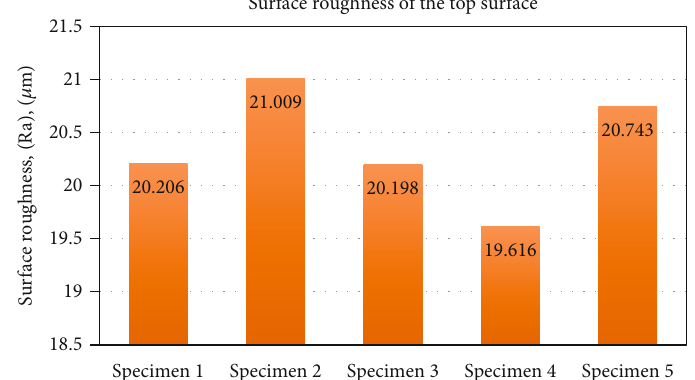
Figure 8: The mean arithmetic deviation ( Ra ) of the top surface of the specimens.